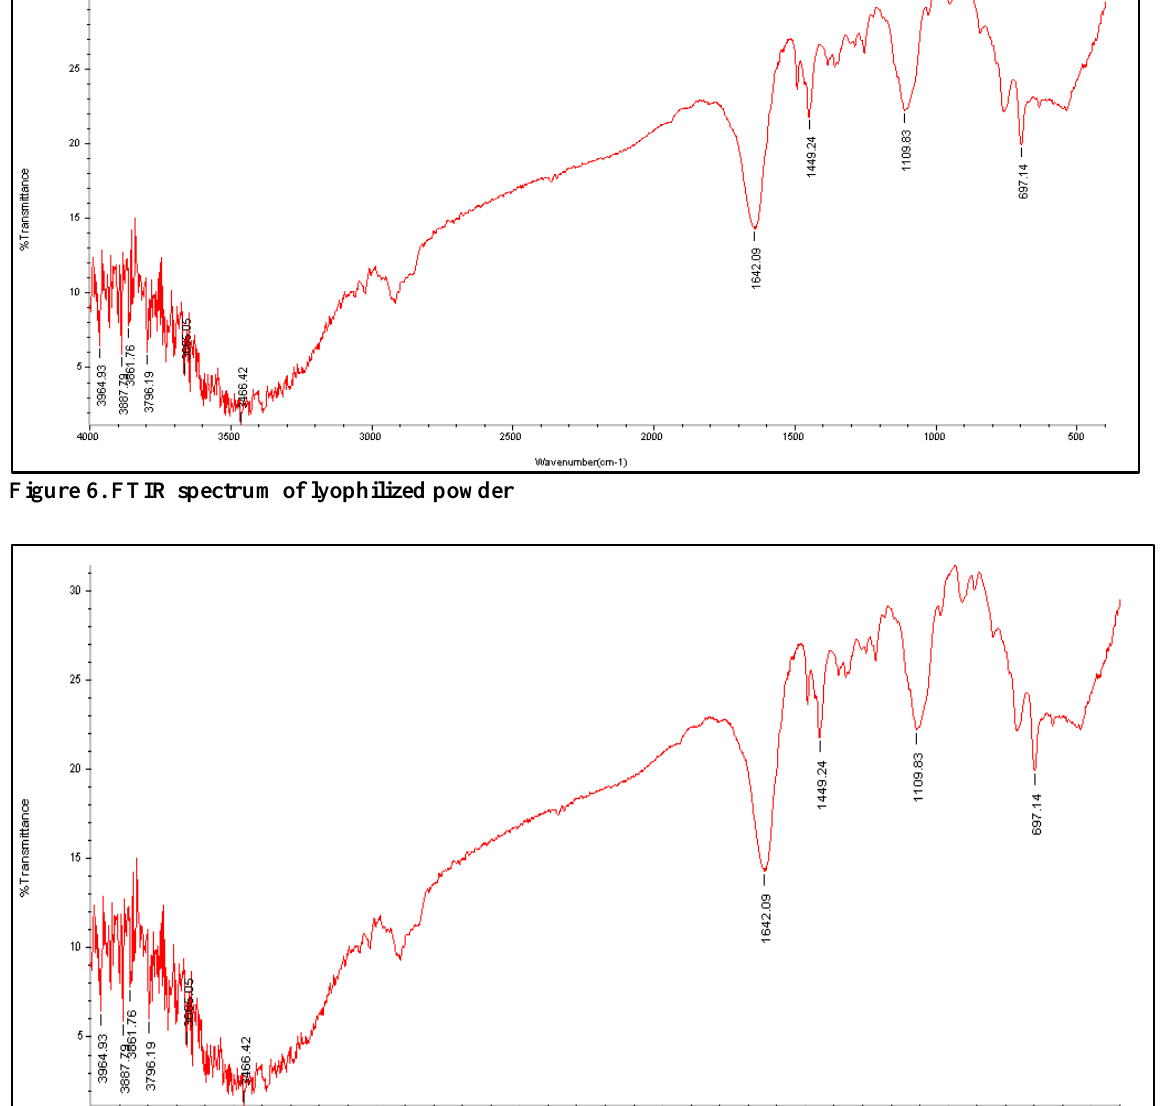
Differential Scanning